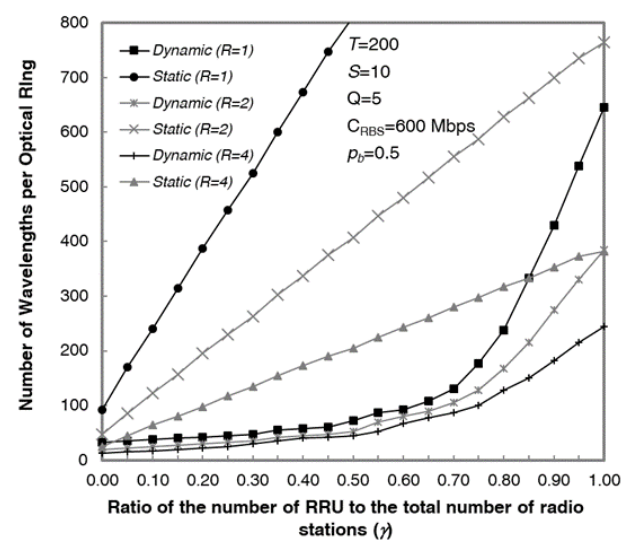
Figure 6. Comparison of the number of wavelengths per optical ring for the static and dynamic scenario cases. The number of wavelengths per optical ring is reported as a function of the used RRU percentage γ in the case of number R of optical rings equal to 1, 2 and 4. The values of the other parameters are chosen as the ones in Figure